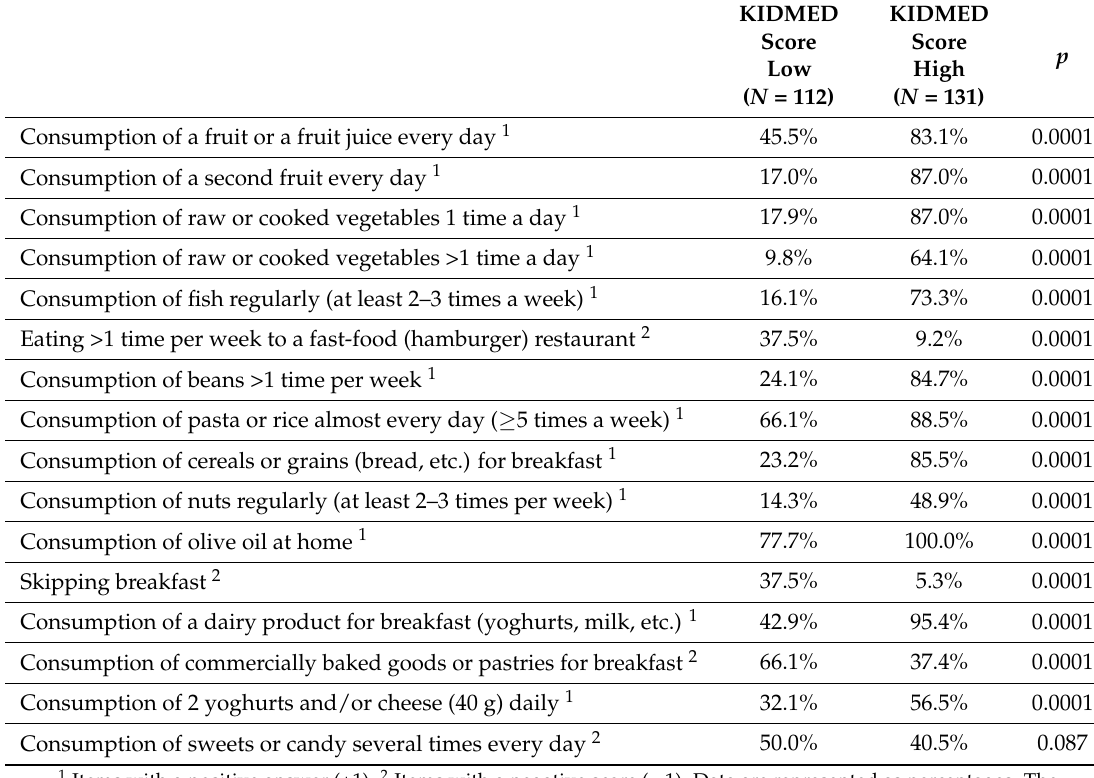
Table A1. Comparison of the each KIDMED item in children with the lowest (score ≤ 3) and the highest adherence (score ≥ 8) to the Mediterranean diet and worst